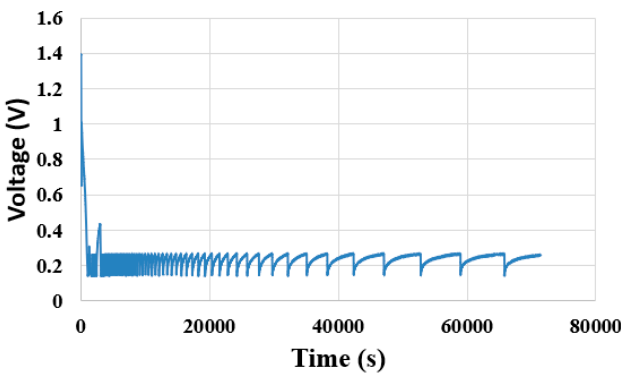
Figure 12. Voltage changes during the proton battery discharge.